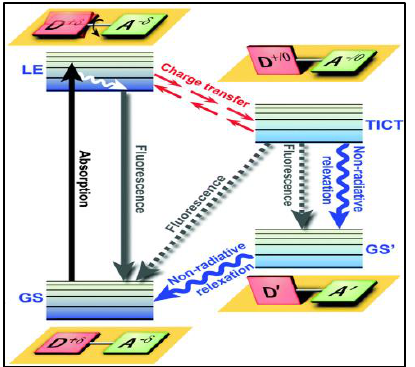
Figure 16. Twisted intramolecular charge transfer (TICT) dynamics. Upon excitation from the GS, the LE state equilibrates rapidly with the TICT state after fast charge transfer (GS = ground state; LE = locally excited state). Adapted with permission from [78]. Copyright (2016) The Royal Society of Chemistry.